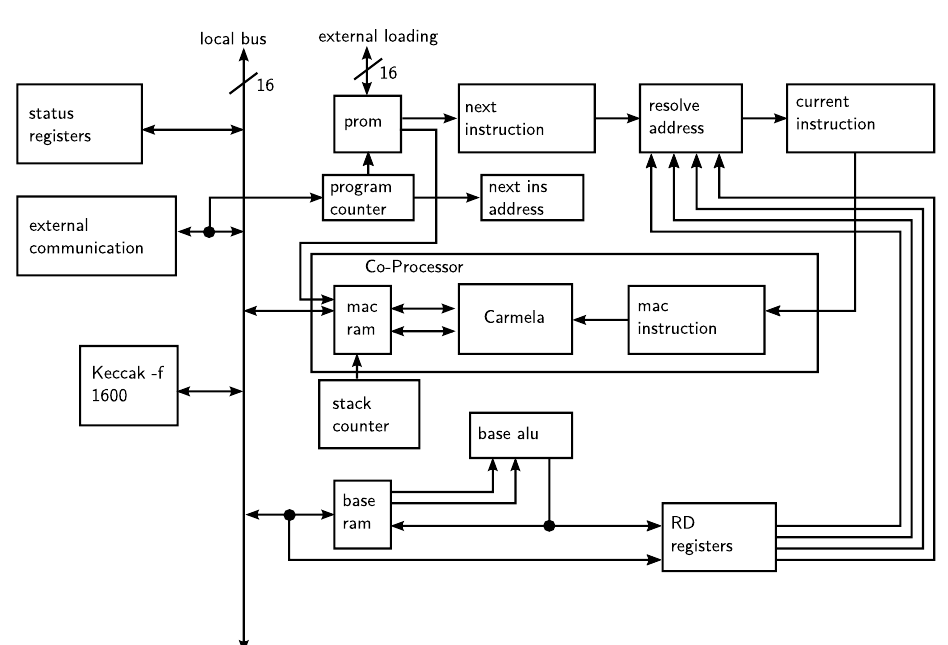
Figure 3: The high-level architecture of the SIKE processor.